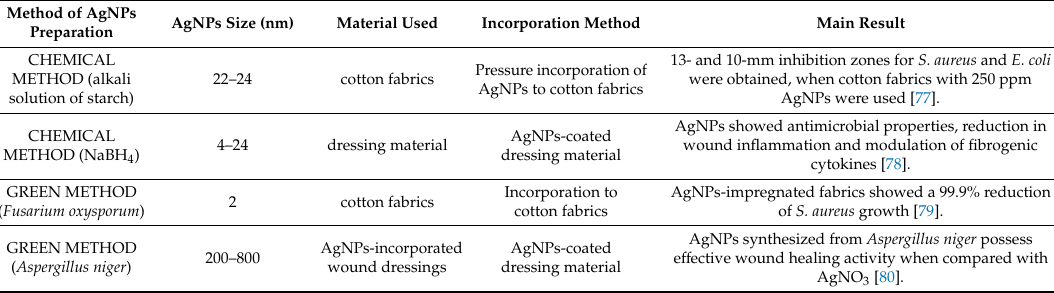
Table 2. Powdered AgNPs for wound treatment